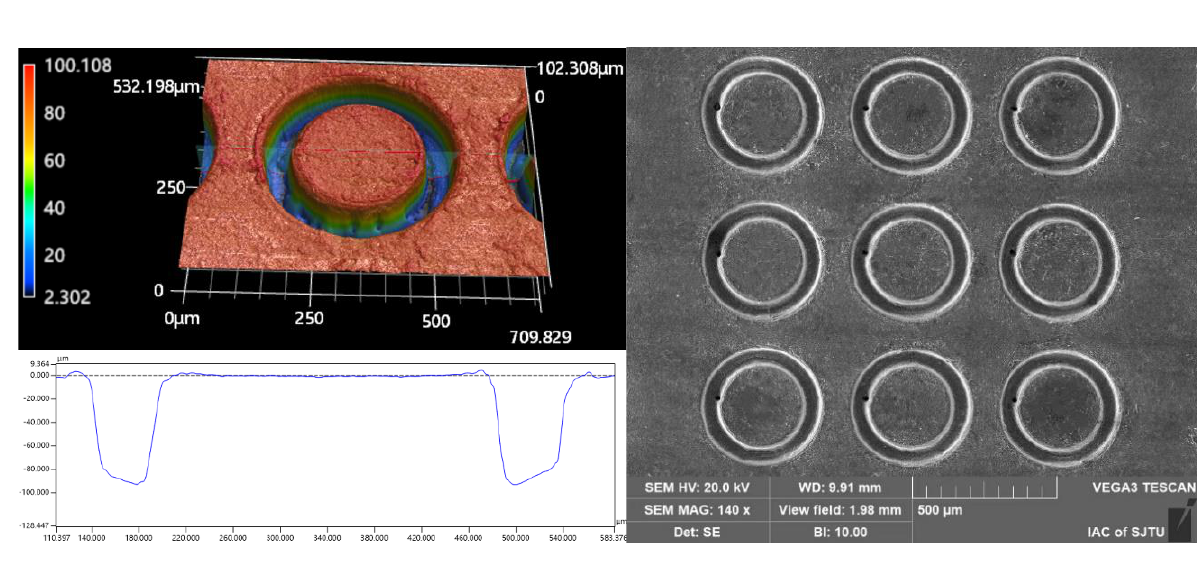
Figure 14. The cross-section profile and SEM image of the micropillars fabricated at the same height of 92 µ m, with different laser machining parameters: ( a ) 50 µ J–0.8 m/s; ( b ) 60 µ J–1.0 Table 3. Effect of different laser pulse energies and laser translation speeds on the micropillar bot- tom angle, MRC, and R a at the same micropillar height of 102 μm.